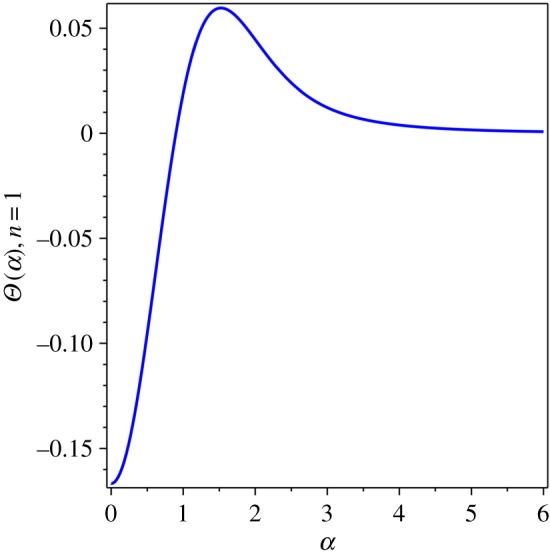
n = 1 term of Θ(α).